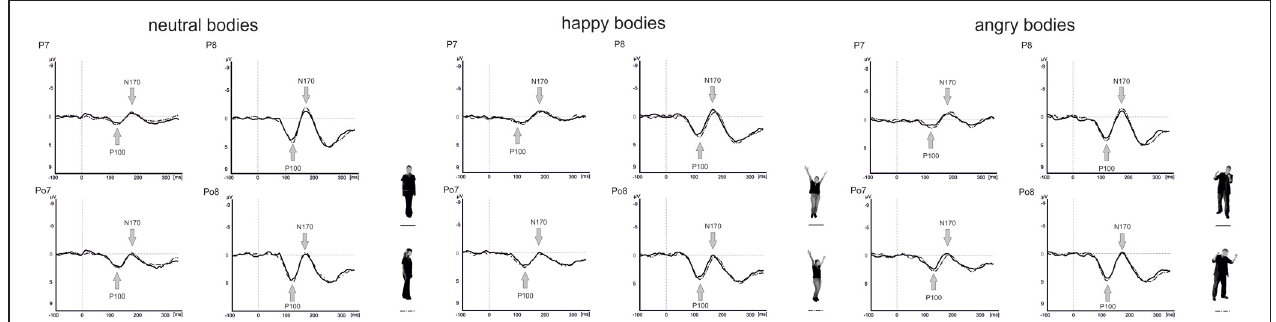
FIGURE 5 | Grand average wave forms for frontal and averted view neutral, happy, and angry